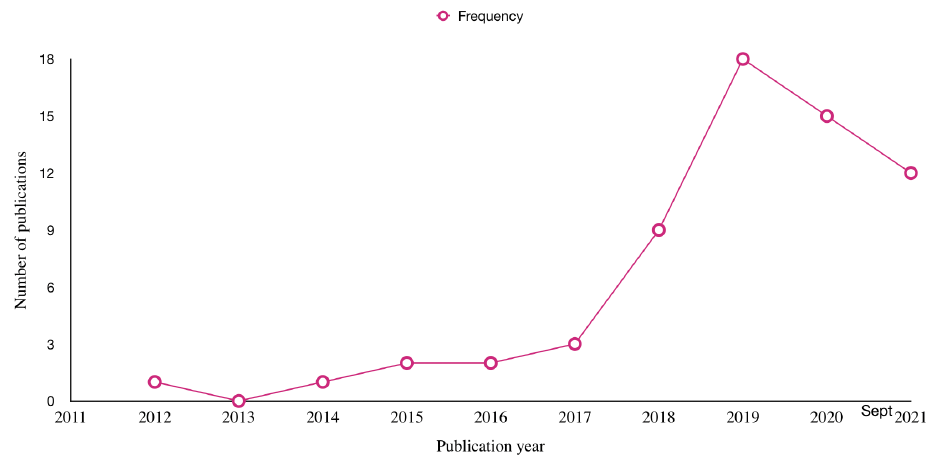
Figure 7. Year-wise distribution of studies. RQ1-2: What is the percentage of studies published in journals and conferences?